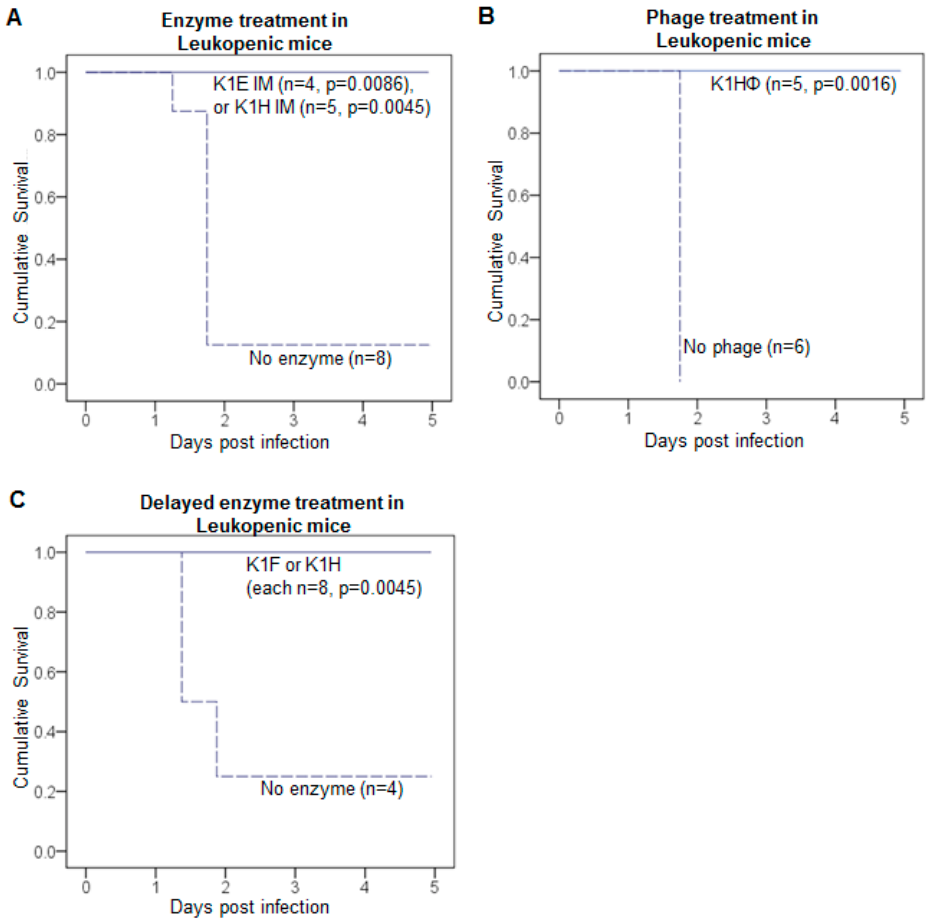
Figure 7. Enzymes and phages rescue infections of leukopenic mice. Total rescue of infections by K1 E. coli in leukopenic mice was achieved by simultaneous treatment with ( A ) K1E or K1H depolymerase; ( B ) K1H phage, and by delayed treatment with ( C ) K1F or K1H depolymerase. Each panel shows Kaplan-Meier survival curves with sample sizes given by n . Infection was initiated by intramuscular (IM) inoculations of 2.2–5.1 × 10 4 CFU of K1 E. coli in the left thigh. Treatment was an IM injection of 20 µ g enzyme or 10 7 phage in the contralateral thigh. Treatment was administered either ( A , B ) immediately at the time of infection or ( C ) 8 h after infection. Mouse survival was monitored for 5 days and the cumulative probability of survival was plotted for each treatment. Log rank test: p values are listed for each treatment compared to no-treatment control.